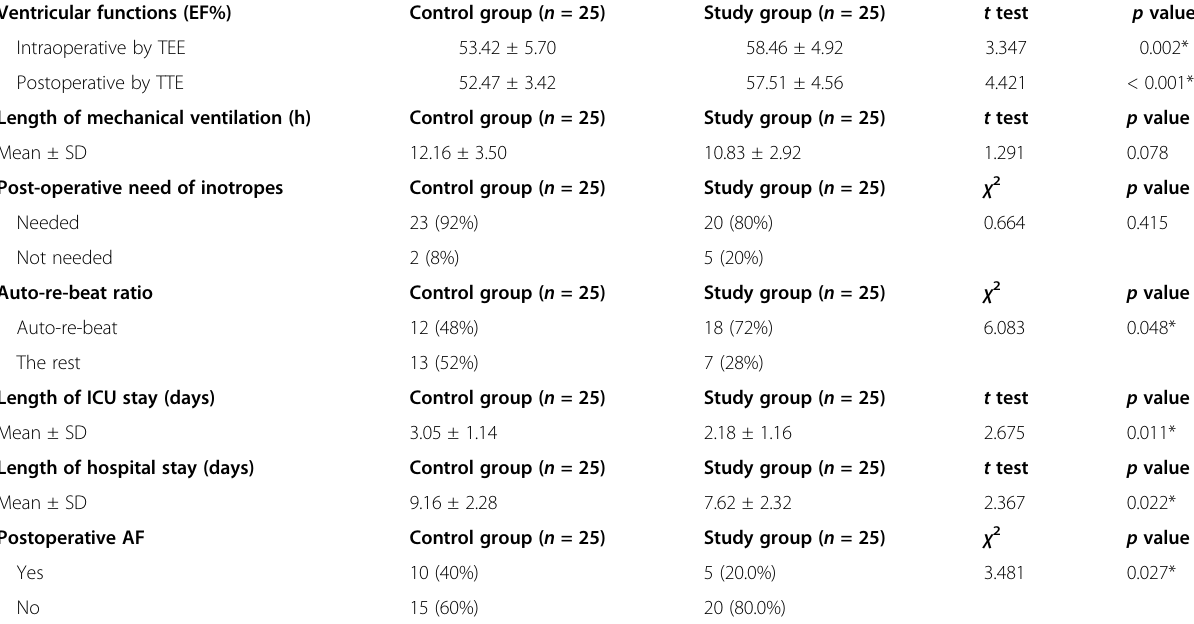
Table 5 Ventricular functions (EF), duration of mechanical ventilation (h), postoperative need of inotropes, auto-re-beat ratio, length of ICU stay (days), length of hospital stay (days), postoperative